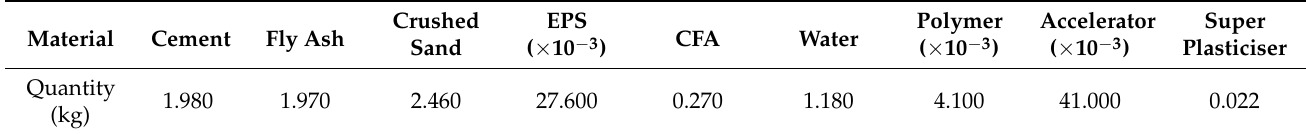
Table 2. Mix design of the CFA-based LW prefabricated mix.